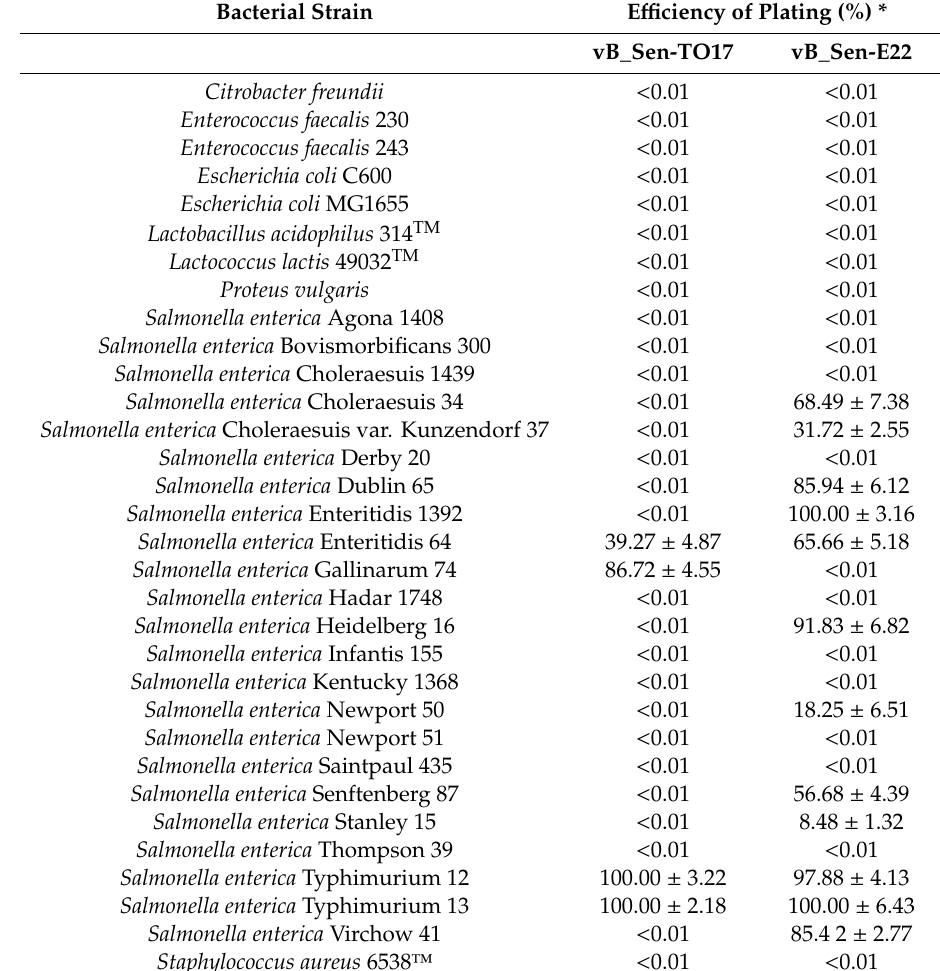
Table 2. Host range of phages vB_Sen-TO17 and